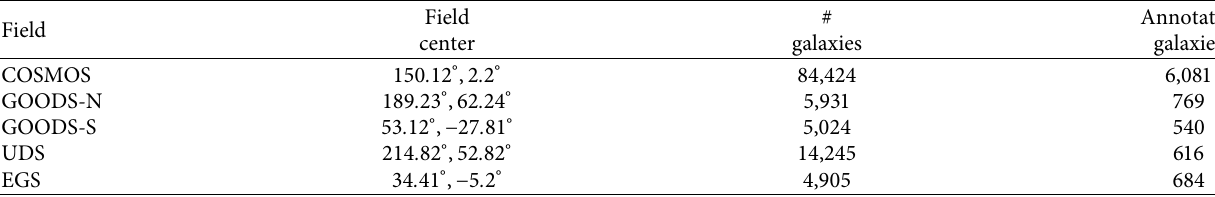
Table 6: The number of galaxies in each of the five HST fields.